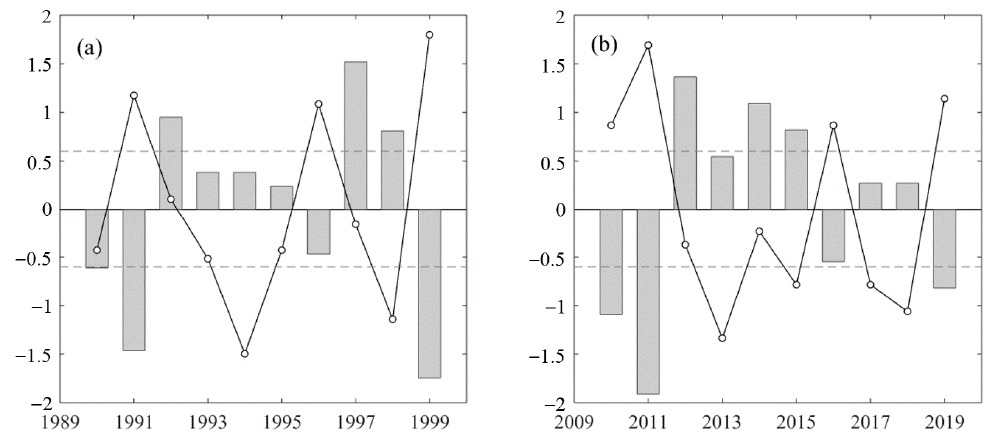
Figure 2. Standardized anomaly of Meiyu onset time from 1990 to 1999 ( a ) and from 2010 to 2019 ( b ).